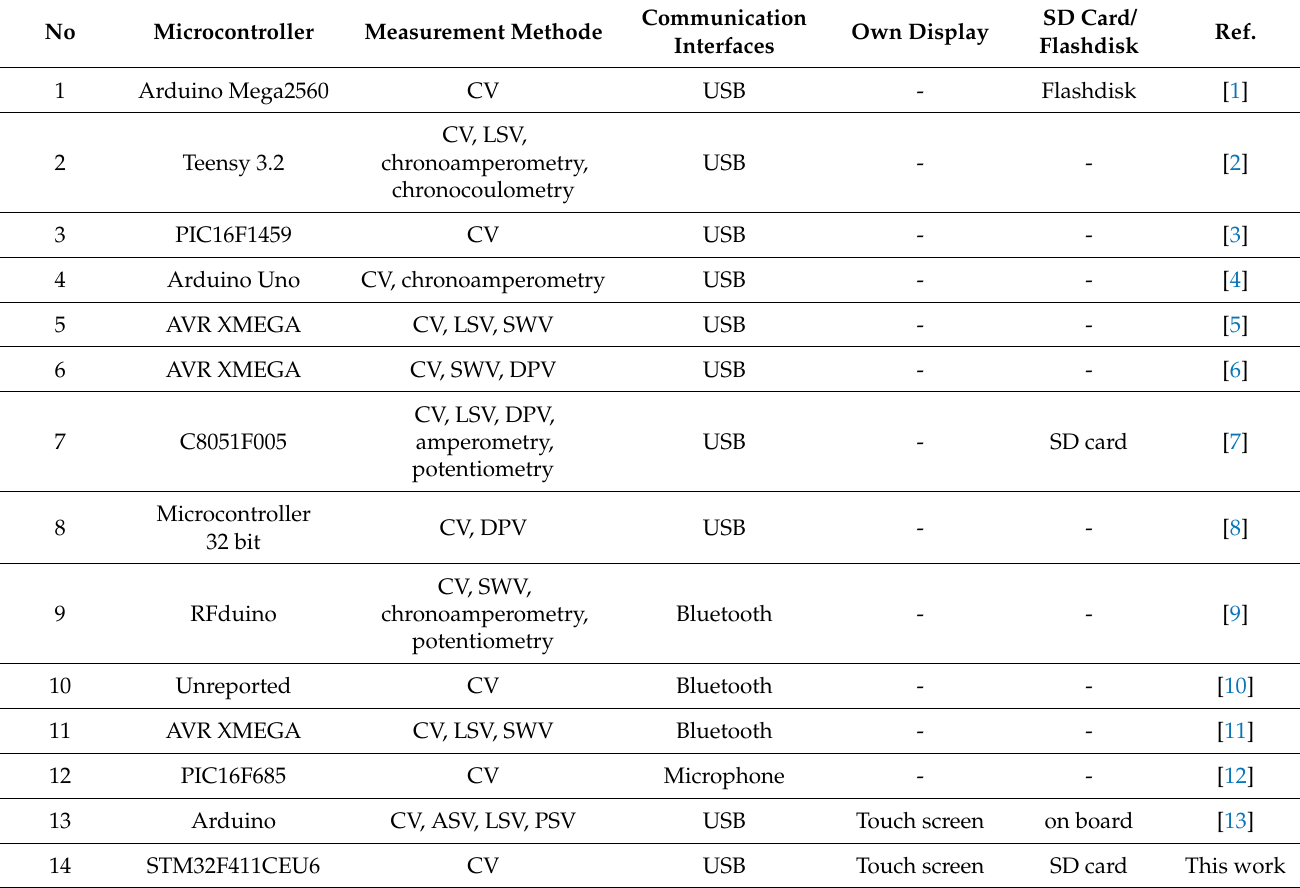
Table 1. Comparison of the main features of the reported